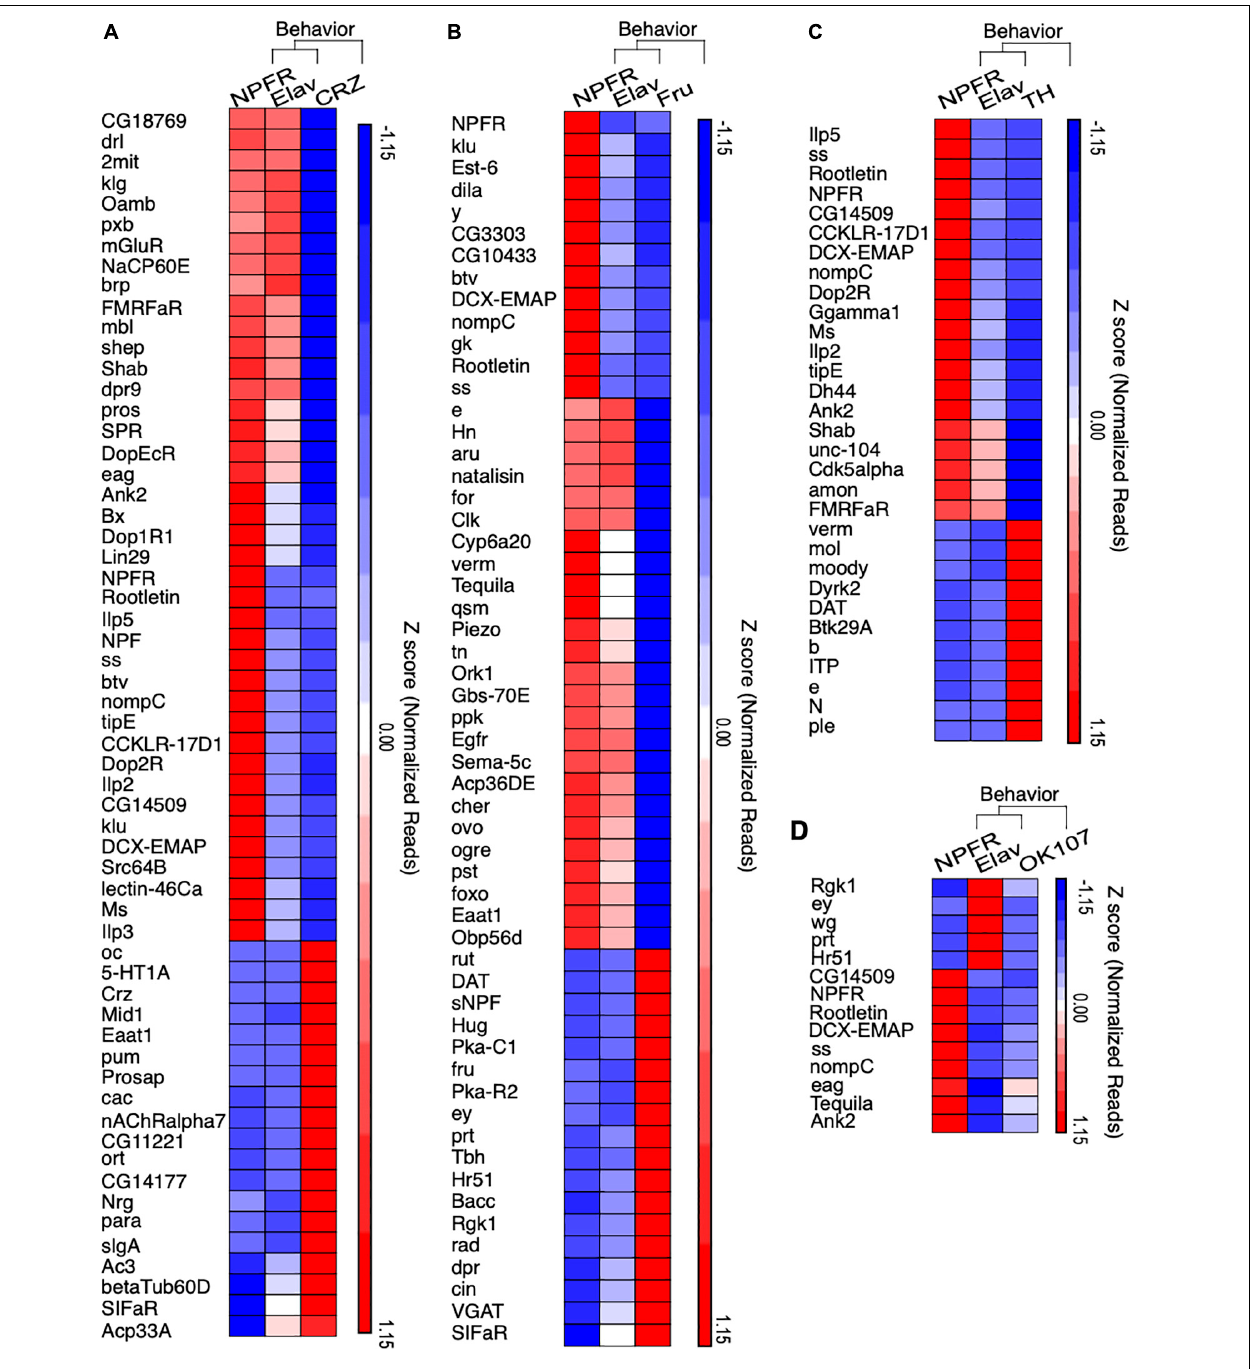
FIGURE 4 | NPFR expressing neurons exhibit enrichment of behavior related genes. (A–D) Hierarchical clustering of statistically overrepresented biological processes that are related to behavior in differentially expressed genes of NPFR expressing neurons compared to Corazonin (CRZ, A ), Fruitless (FRU, B ), Dopamine producing (TH, C ) neurons and Mushroom bodies neurons (OK107, D ). Biological overrepresentation was performed using PANTHER. Clustering analysis was performed using Partek.